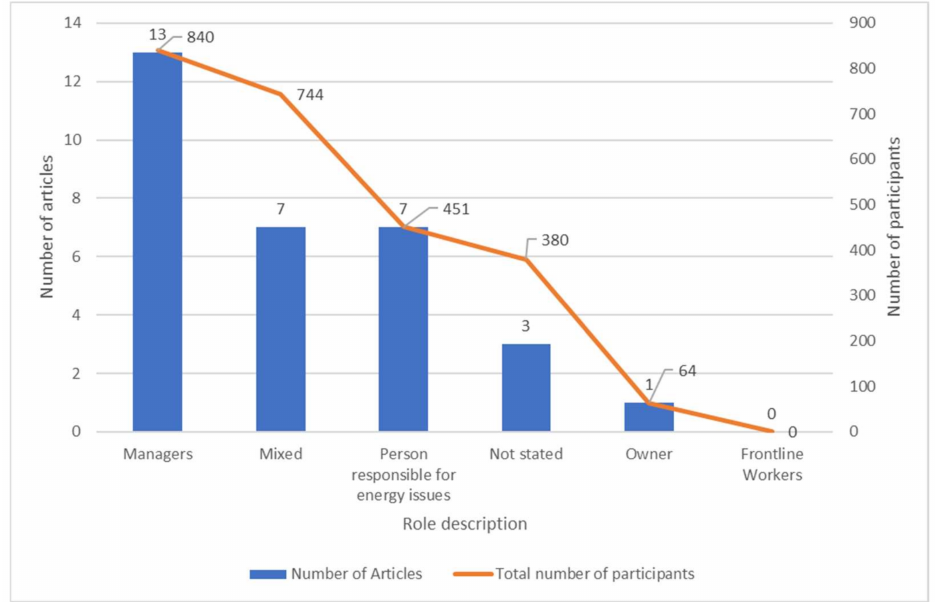
Figure 3. Number of articles and participants according to role description for studies using survey and